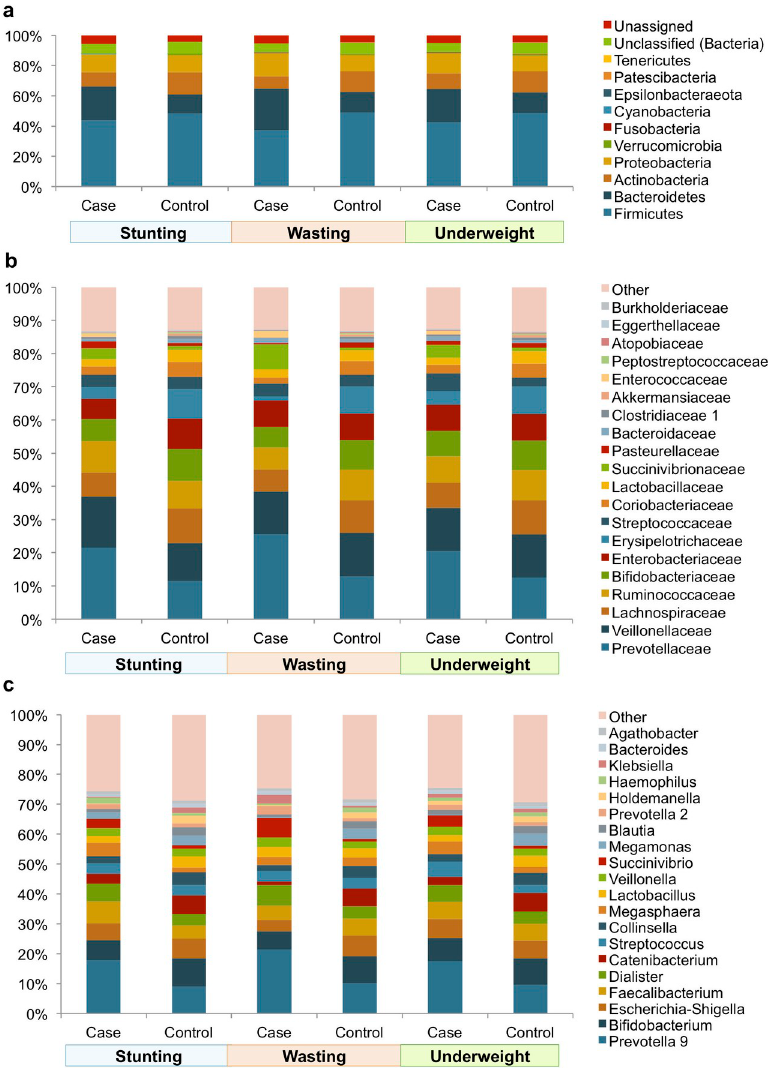
Fig 2. The fecal microbial composition profiles of 18–24 month old Indian children. Fecal microbial composition profiles at the ( A ) phylum level and ( B ) family level and ( C ) genus level within the case and non-case samples of stunting, wasting and underweight groupings. Only the top 20 families with most relative abundance are labelled in (B) and (C). The remaining families and genera including unclassified and unassigned have been grouped together as